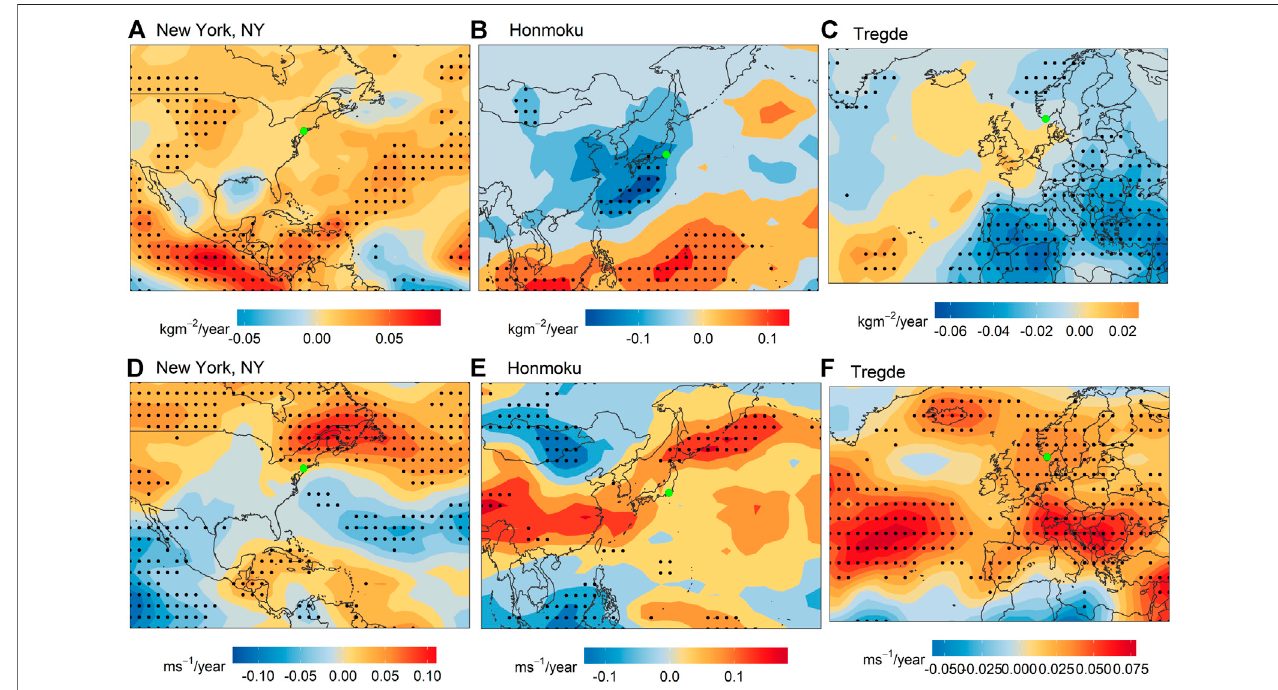
FIGURE 9 | Trends in (A – C) precipitable water contents (kgm − 2 /year) and (D – F) vertical wind shear (ms − 1 /year) during precipitation under extreme storm surge in tidegaugeNewYork,NY (A,D) ,Honmoku (B,E) ,andTregde (C,F) .Locationsofthetidegaugesinterestedaredenotedbythegreenspots.Stippledregionsrepresent areas with signi fi cant trends ( α (cid:1)